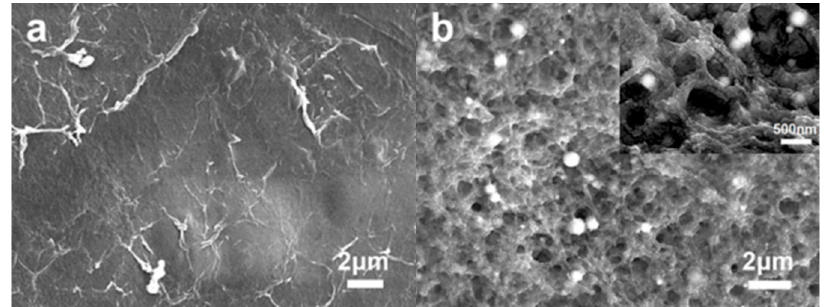
Figure 3. Scanning electron microscopy (SEM) images of ( a ) CaAlg and ( b ) CaAlg/nano-Cu 2 O. The inset in ( b ) is the magnified image.